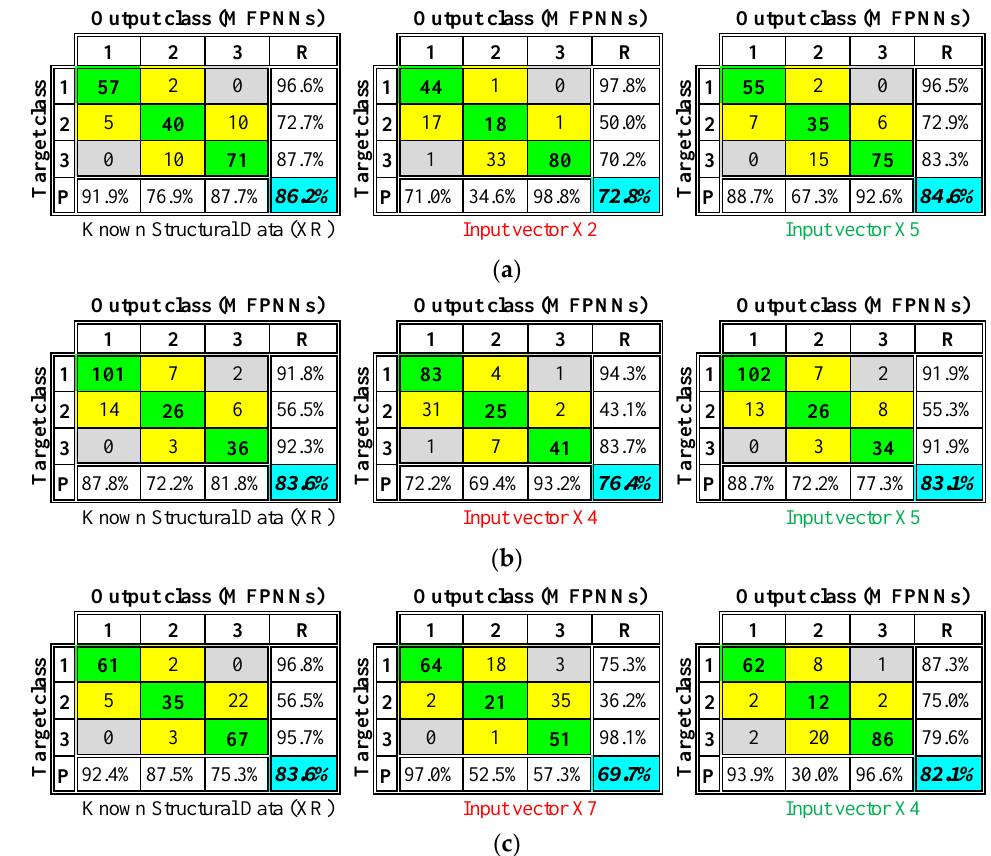
Figure 17. CMs correspond to the classifications extracted by the used MFPNNs considering input vectors with assumed values for the unknown structural parameters: ( a ) for BB, ( b ) for FIB, and ( c ) PB.